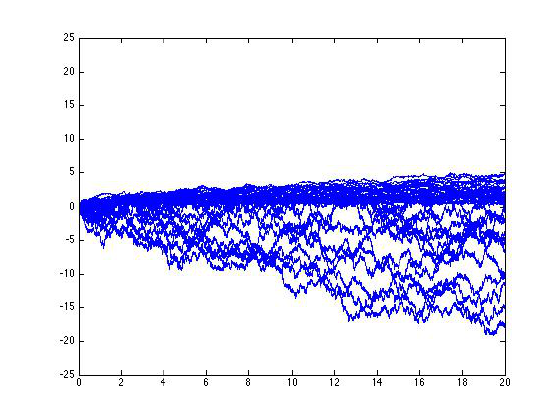
Figure 9: 50 simulations of X − Y in the correlation local model with parameters ν = 0, η = 0.5 , ρ min = −0.9 and ρ max = 0.9 between time t = 0 and t = 20 and a time step of